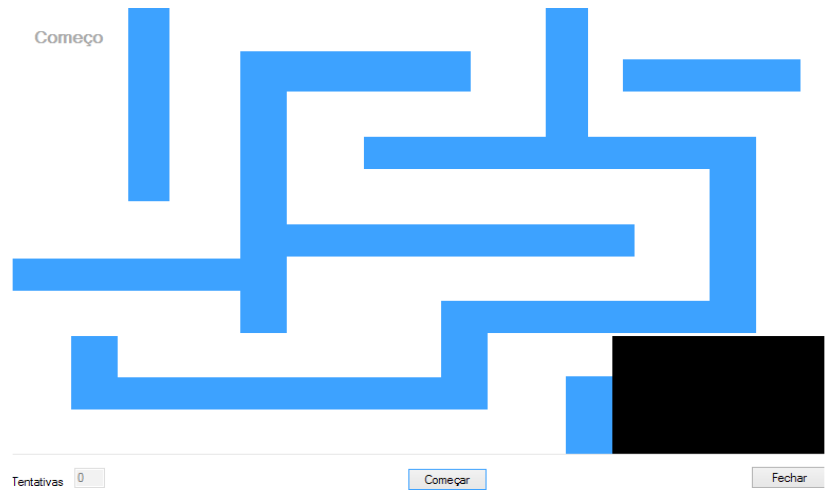
Figure 1 - Maze test adopted for the assessment